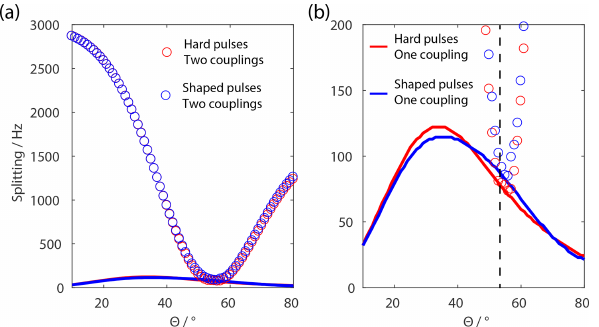
Figure 4. Calculated residual splitting of FSLG sequence in a homonuclear three-spin system as a dependence of the effective- field angle and implementations using rectangular pulses (red) and shaped pulses (blue). The splitting due to the residual coupling is shown without chemical-shift scaling due to the effective-field axis. The second-order cross terms are minimized around the magic an- gle (circles) but the third-order terms resulting from a single dipolar coupling are never fully removed (solid line). (a) Full scale of split- ting as a function of the effective-field angle. (b) Zoom on the resid- ual splitting contributions up to 200Hz. The MAS frequency was set to 6.25kHz, the effective field to 125kHz, the relative dipole orientation to 45 ◦ , and the dipolar couplings to 40kHz for the sin- gle coupling and to 10kHz for the second coupling, and powder averaging was applied. The black dashed line represents θ = θ m